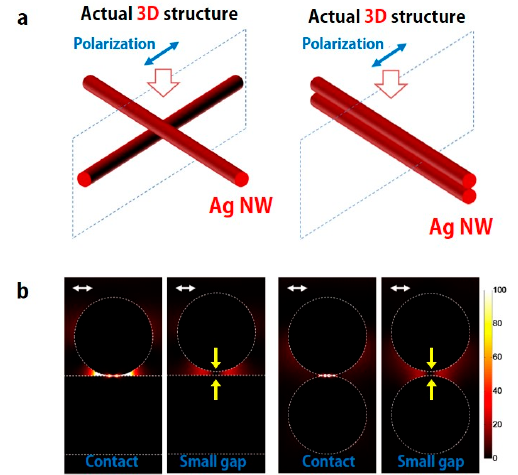
Figure 5. Finite difference time domain (FDTD) simulation at the junction of crossed Ag NWs. ( a ) Simulation layout of two crossed (left) and stacked (right) Ag NWs. ( b ) Electromagnetic field distribution at the junction with various conditions: crossed/contact, crossed/small gap, stacked/contact, stacked/small gap of two Ag NWs. The white arrow is the polarized direction of irradiated light. The yellow arrow indicates a small gap between two Ag NWs.